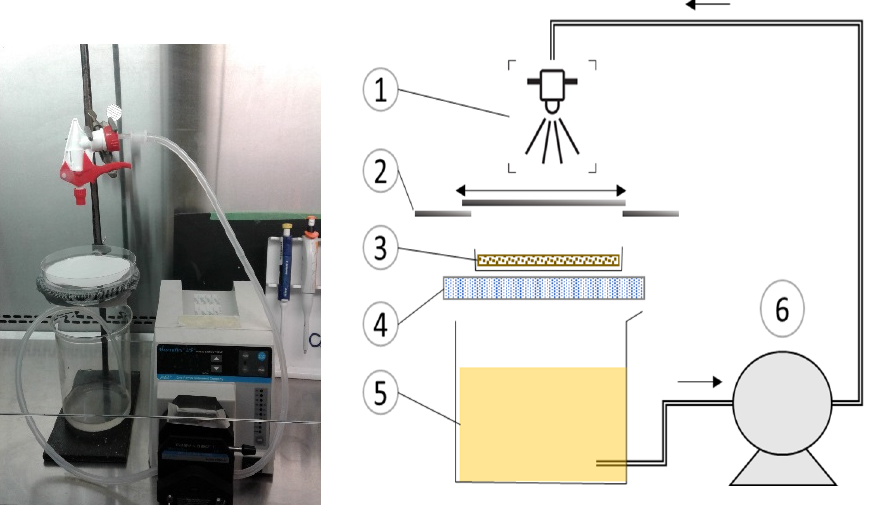
Figure 1. Customized spraying system. (1) 0.9-mm spray bottle nozzle, (2) customized shutter system, (3) 90-mm paper circle, (4) metallic 50-mesh screen, (5) antimicrobial formula, and (6) Masterflex peristaltic pump.